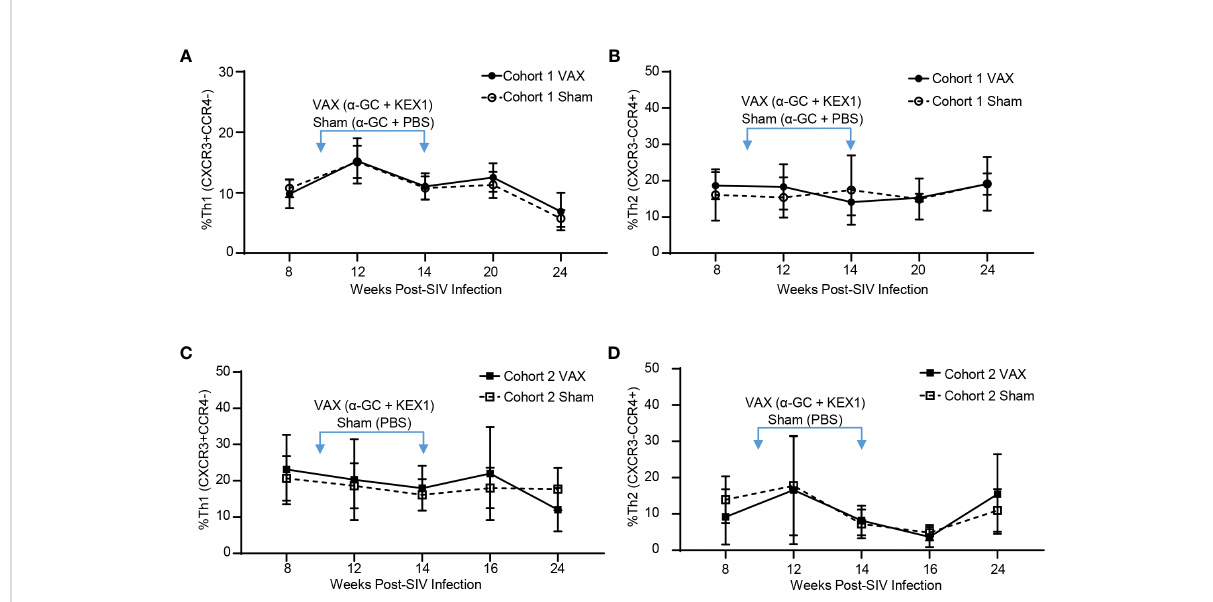
FIGURE 4 Evaluation of T effector subsets following vaccination with alum+KEX1 and a -GC+KEX1 in Rhesus macaques. Frequency of (A) Th1 (CXCR3+CCR4-) and (B) , Th2 (CXCR3-CCR4+) effector T cells in Cohort 1 following therapeutic boosting at 10 and 14 weeks post-infection (blue arrows) as indicated. Frequency of (C) Th1 and (D) Th2 effector T cells in Cohort 2 following therapeutic vaccination. Data represents the mean ± SD. Statistical signi fi cance between VAX and Sham cohorts over time was evaluated by repeated measures mixed modeling analysis using the Geisser-Greenhouse model correction and Sidak correction for multiple comparisons.